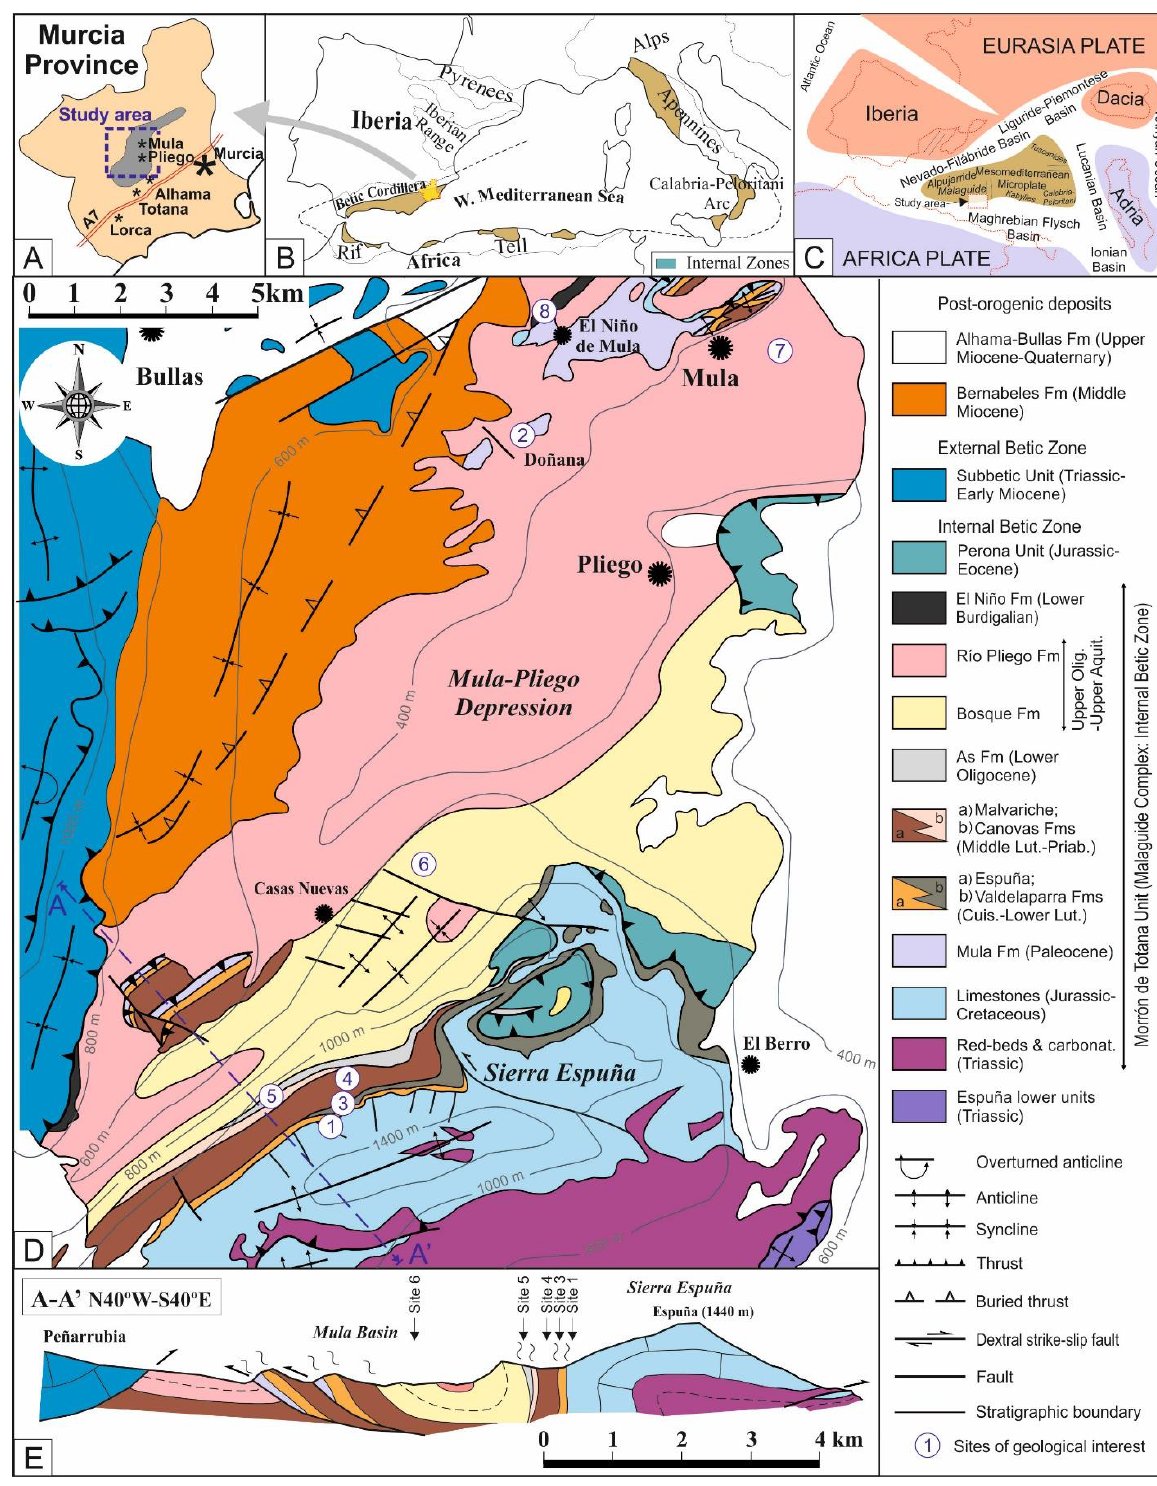
Figure 1. Geographical and geological location of the Sierra Espuña area (modified from [1]). ( A ) Geographic locations in the Murcia province (SE Spain). ( B ) Geographic location in the framework of the western Mediterranean alpine chains. ( C ) Paleogeographic sketch in Cretaceous times of the western Mediterranean area. ( D ) Geological map of the Sierra Espuña area including Sierra Espuña s.s. and the Mula-Pliego Depression. ( E ) Geological cross-section of the area located in ( D ). The location of the sites of geological interest appears in ( D ). This area belongs to the Malaguide Complex from the Internal Betic Cordillera [2,3]. The Internal Zone of this cordillera usually shows metamorphic rocks (Nevado-Filabride